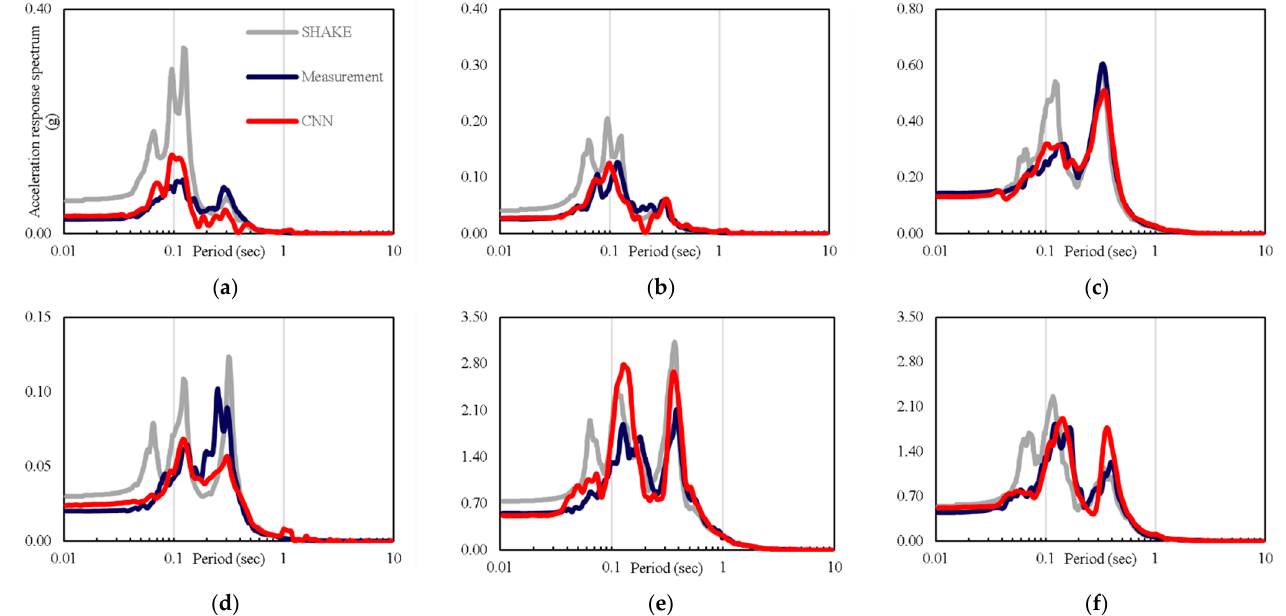
Figure 12. The six samples of acceleration response spectra measurements and predictions at site FKSH19. ( a ) FKSH191611240623.EW. ( b ) FKSH191611240623.NS. ( c ) FKSH191908041923.EW. ( d ) FKSH192004200539.NS. ( e ) FKSH192102132308.EW. ( f ) FKSH192102132308.NS.